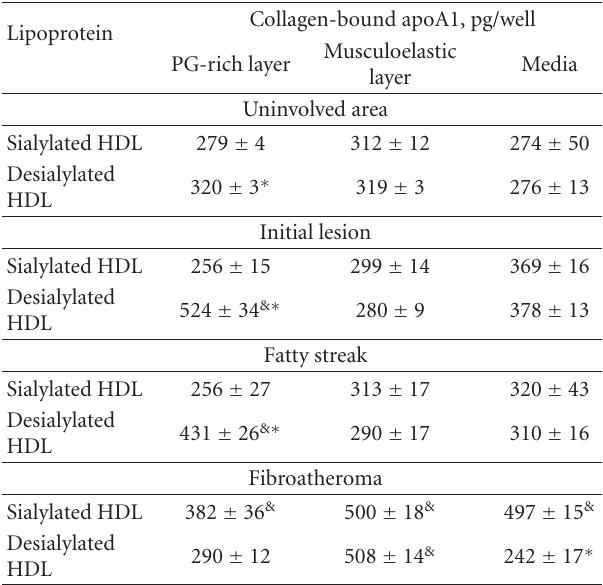
Table 3: Binding of sialylated and desialylated LDL to collagen isolated from two layers of the intima and the media of uninvolved and atherosclerotic areas of human aorta.